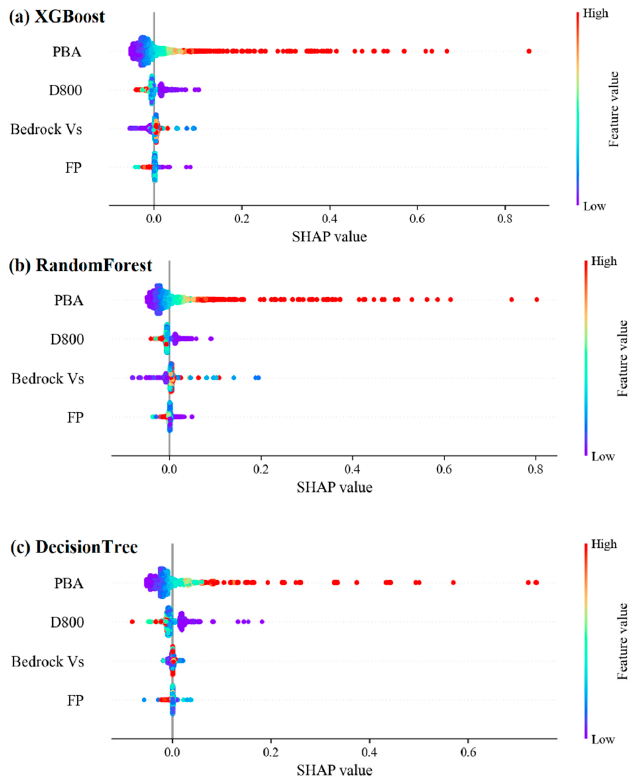
Figure 12. The SHAP summary plot of all input features for ( a ) XGBoost, ( b ) Random Forest, ( c ) Decision Tree.